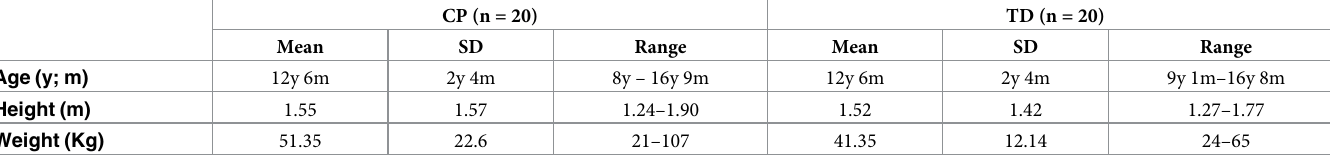
Table 1. Mean, standard deviation and range for the general characteristics of the